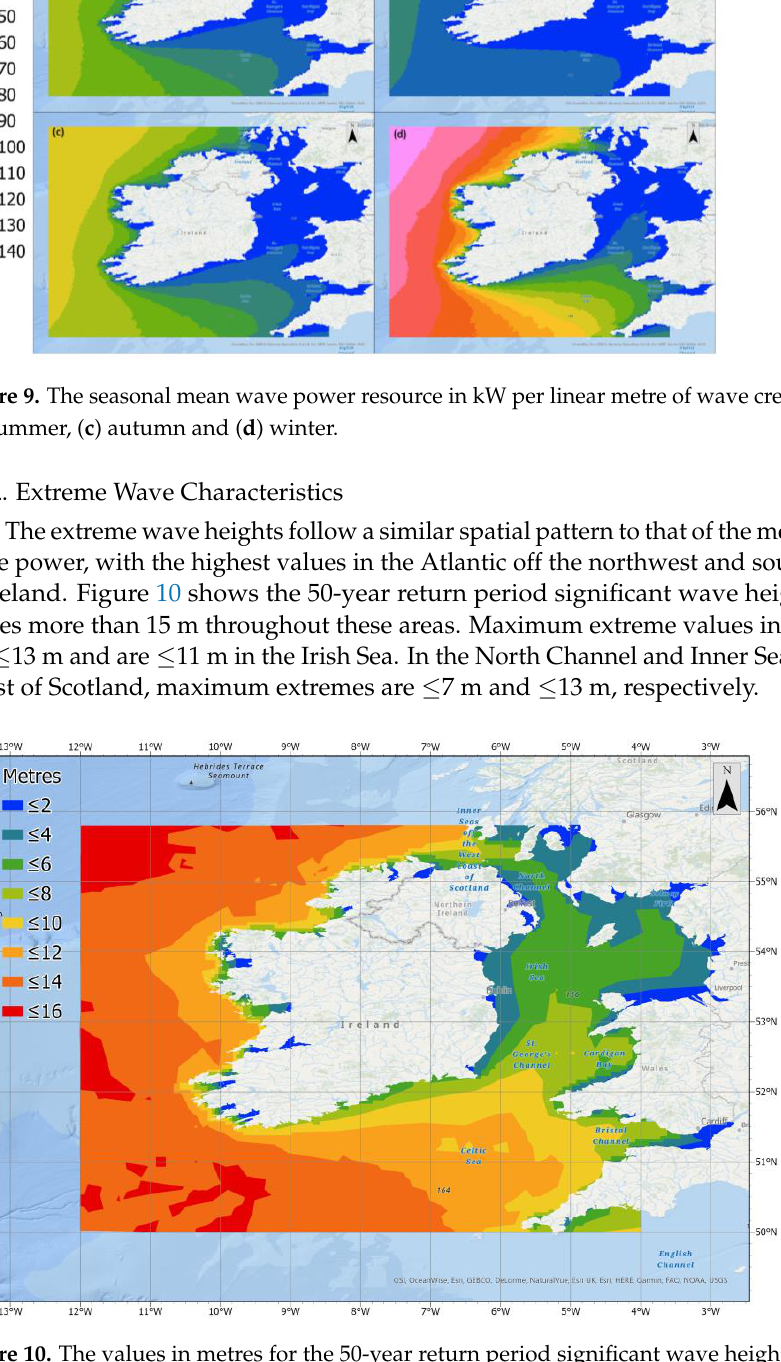
Figure 8. The annual mean wave power resource in kW per linear metre of wave crest (kW/m).